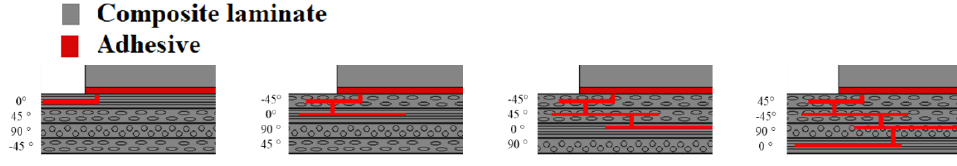
Figure 20. Effect of 0 ◦ layer distance from surface in quasi isotropic laminate. Adapted from [140].